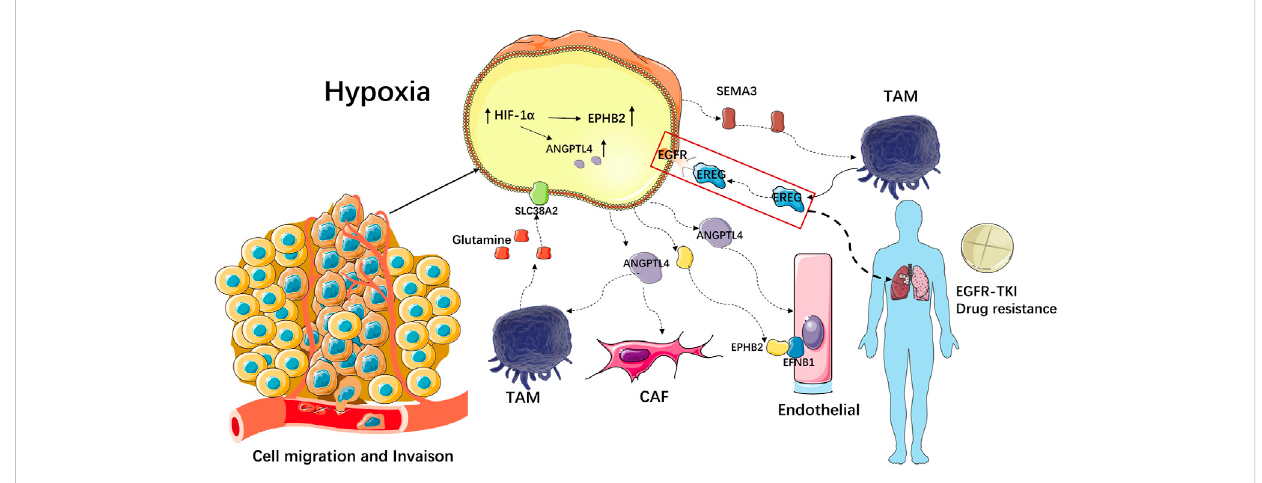
FIGURE 14 Mechanism of invasive metastasis and immunosuppressive effect of